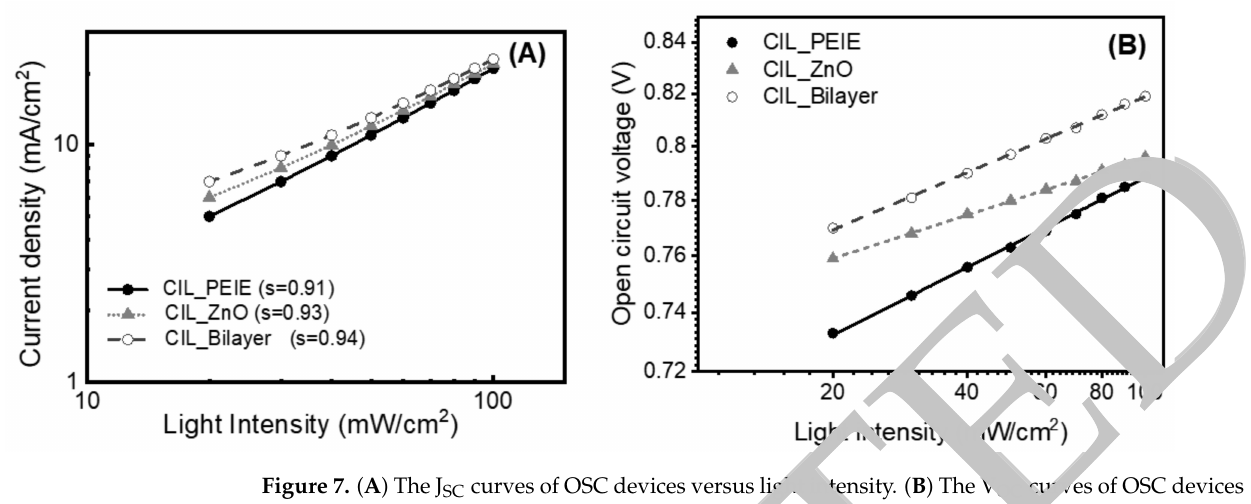
Figure 7. ( A ) The J SC curves of OSC devices versus light intensity. ( B ) The V OC curves of OSC devices versus light